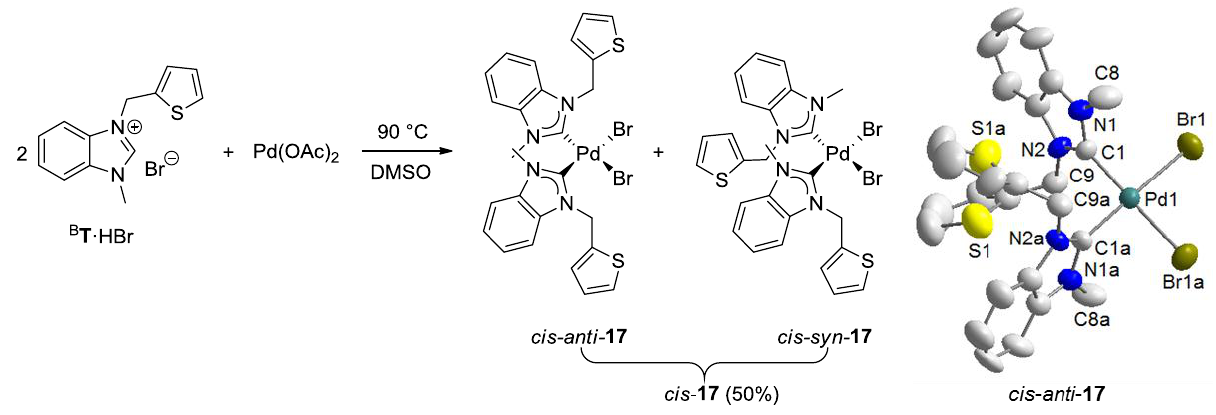
Figure 10. Synthesis of thiophene-functionalized Pd(II) complex cis - 17 and its molecular structure [13].